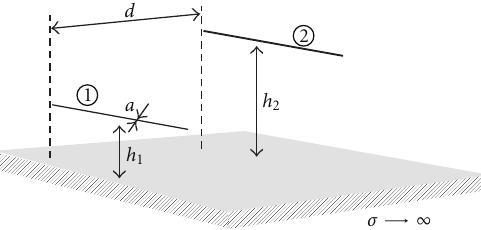
Figure 12: Transient current at the wire center, L = 1m, a = 2mm, h = 0 . 25, ε r = 10.